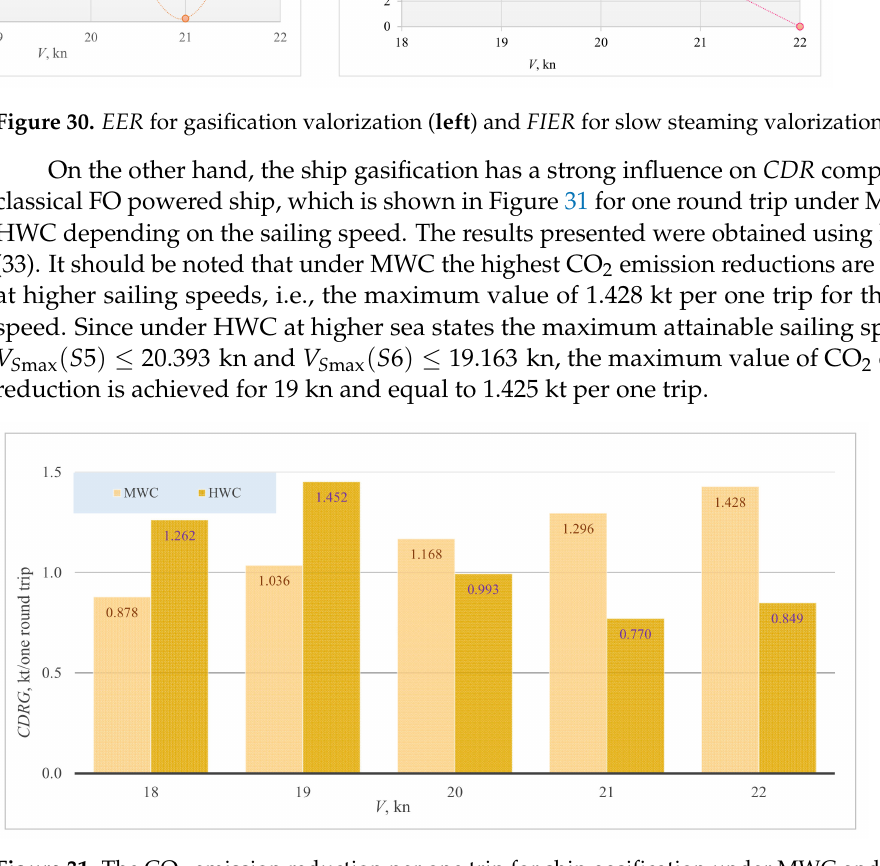
Figure 31. The CO 2 emission reduction per one trip for ship gasification under MWC and